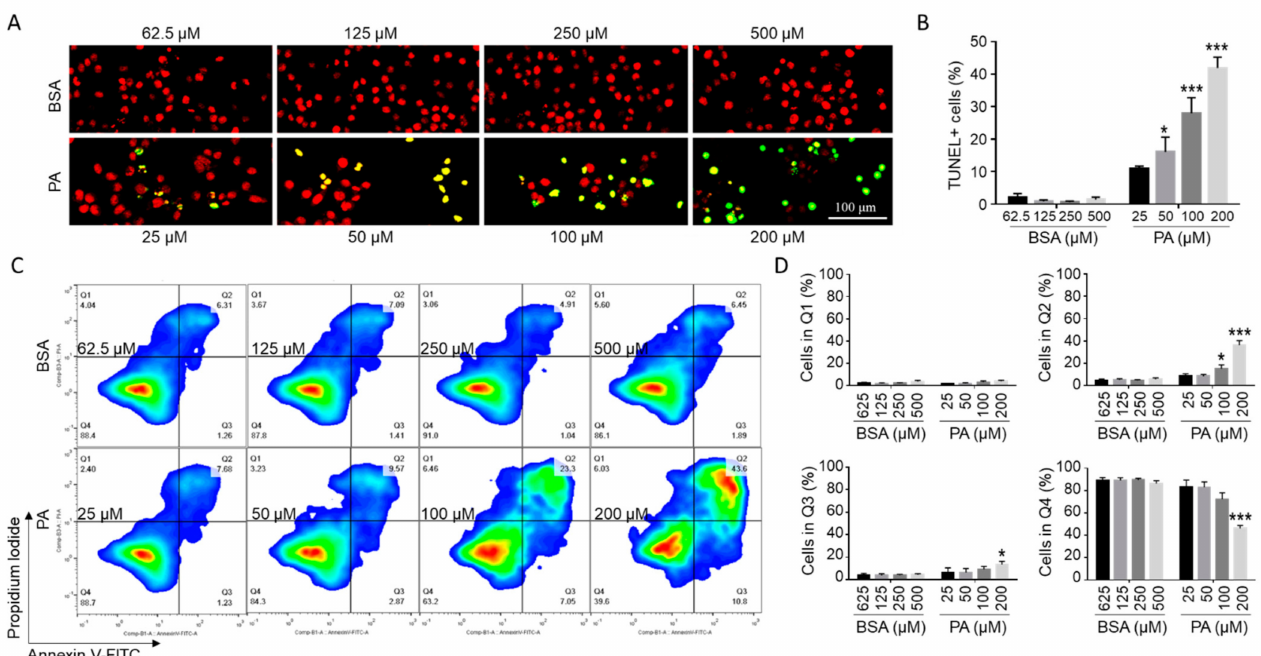
Figure 2. PA-induced microglial cell death. ( A , B ) Detection of cell death by TUNEL assay (green) with nuclei stained with PI (red) following treatment with different concentrations of PA and BSA control for 24 h with representative confocal images presented in A and quantitated data presented in B (mean ± SE). ( C , D ) Detection of cell death by flow cytometry after staining the cells with FITC-conjugated Annexin V and PI following treatment with different concentrations of PA and BSA control for 24 h in serum-free media with representative flow cytometry contour plots shown in C and quantitated data for each quadrant shown in D (mean ± SE). Top left quadrant (Q1) represented Annexin V − /PI + necrotic cells. Top right quadrant (Q2) represented Annexin V + /PI + late apoptotic and/or necrotic cells. Bottom right quadrant (Q3) represented Annexin V + /PI − early apoptotic cells. Lower left quadrant (Q4) represented Annexin V − /PI − live cells. The values presented were representative of three independent experiments (mean ± SE). Statistical analysis was performed using two-way ANOVA followed by Tukey’s multiple comparison test. * p < 0.05 vs. corresponding BSA control; *** p < 0.001 vs. corresponding BSA